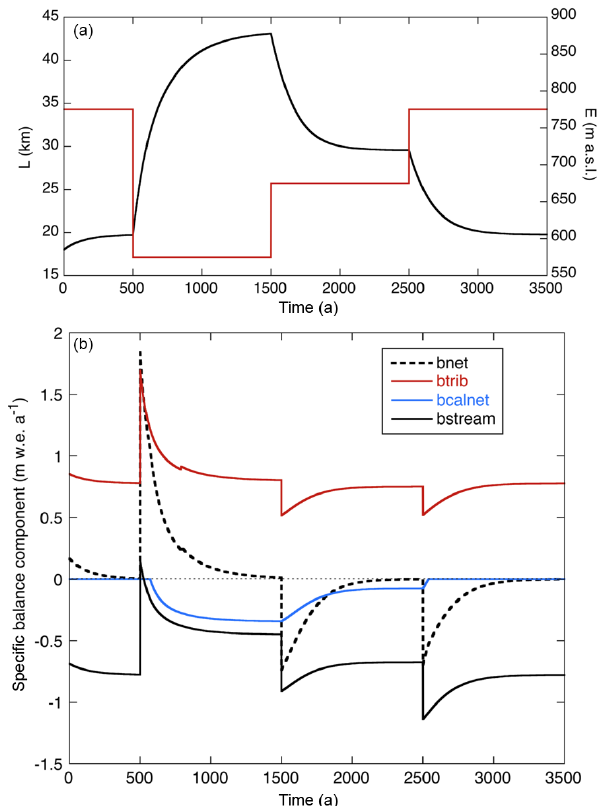
Figure 5. (a) Evolution of glaciers length L (black) for stepwise changes in the equilibrium-line altitude E (in red). (b) The corre- sponding components of the mass